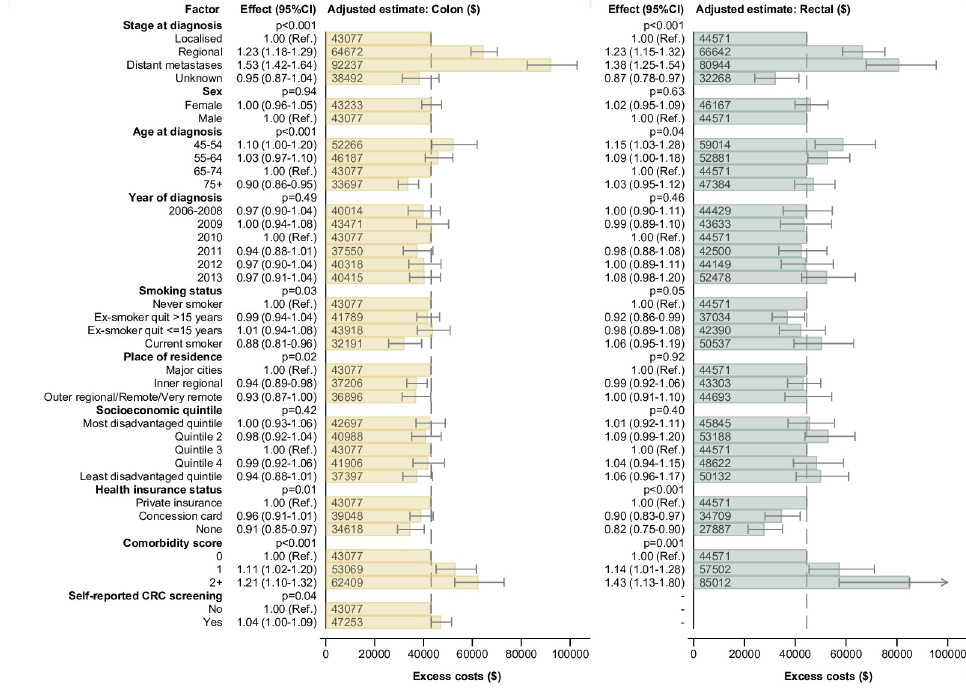
Fig 3. Multivariable adjusted excess costs of colon and rectal cancer in the initial phase of care. Notes: The dashed vertical line is the adjusted excess cost for a case in the reference category for all characteristics (i.e. $43,077 for colon cancer cases and $44,571 for rectal). For each category of a characteristic, the estimate shown reflects the adjusted excess cost for a case with all other characteristics in the reference category. To allow regression with non-negative values, the models were constructed using an offset of +$50,000; this offset was then deducted to obtain the adjusted estimates shown in the figure.